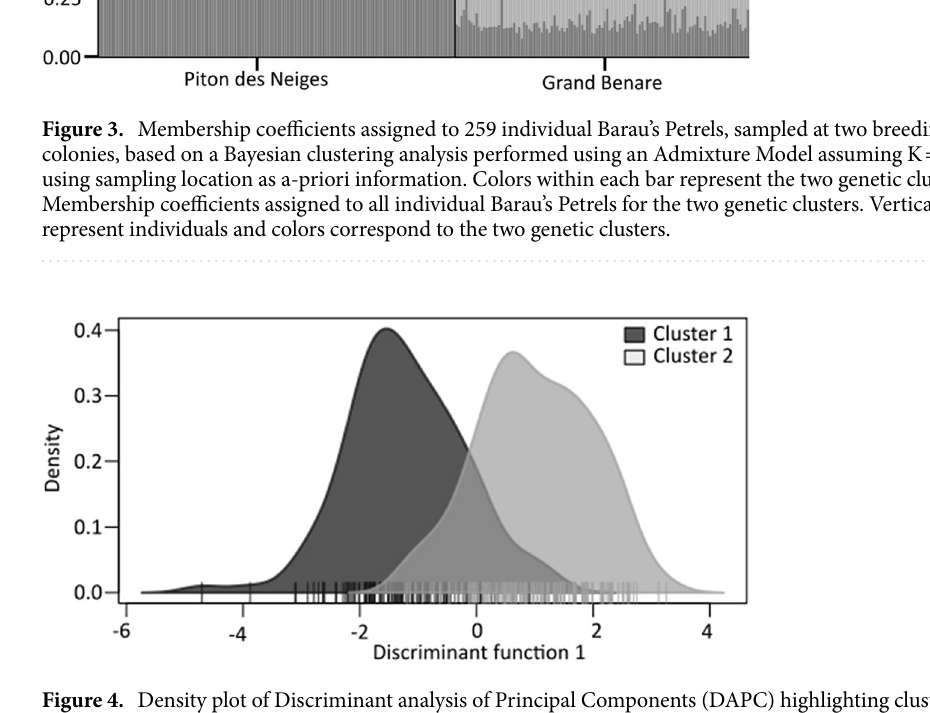
Figure 4. Density plot of Discriminant analysis of Principal Components (DAPC) highlighting clustering among 259 individual Barau’s Petrels, sampled at two breeding colonies, assuming K = 2 and using the first discriminant function and 80 principal components. Vertical bars represent individual assignments of 259 Barau’s Petrels from the Piton des Neiges (dark grey) and Grand Benare (pale grey) colonies. The densities of individuals are plotted along a given discriminant function, with different colors representing different groups. Here, the clear separation between Barau’s Petrels sampled at the Piton des Neiges and Grand Benare breeding colonies is visible.